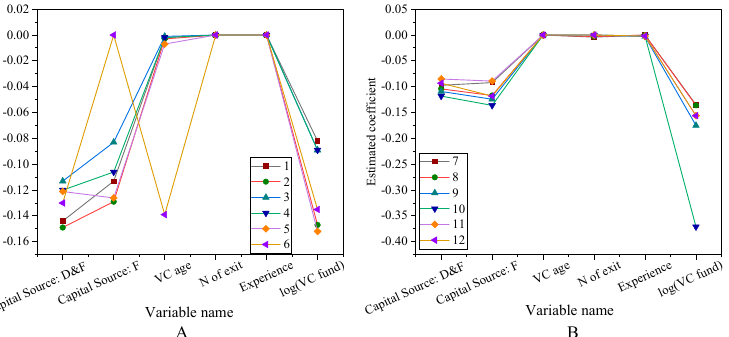
Figure 13. Robustness test for portfolio successful exit rates ( A ) Other variables 1–6; ( B ) Other variables 7–12.